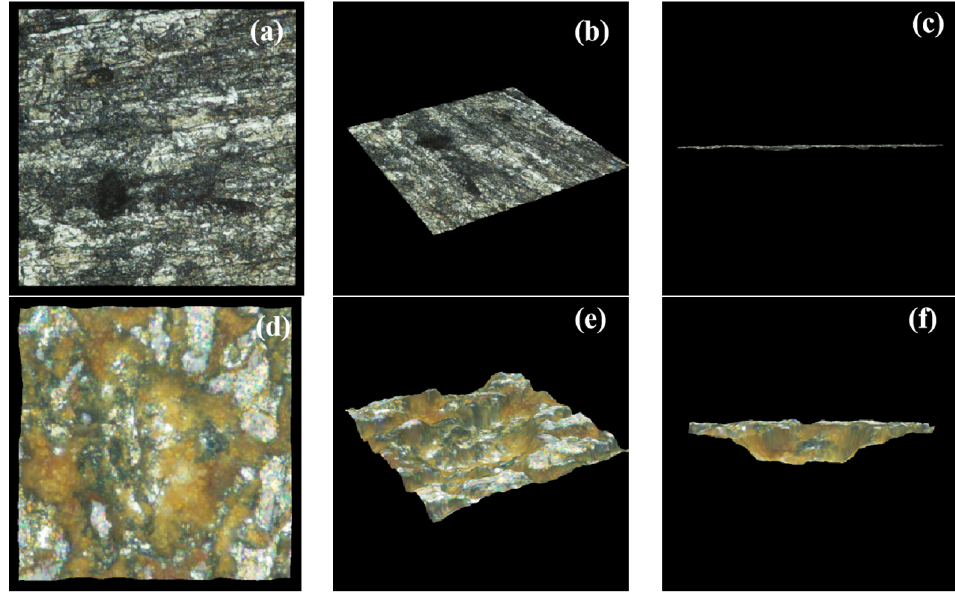
Figure 9. Three-dimensional profilometry measurement of corroded samples after removing corrosion products at pH = 3.10 for ( a − c ) the bare electrode, ( d − f ) S8 − coated electrode. Table 3. Three − dimensional profilometry measurement depth at pH = 3.10.